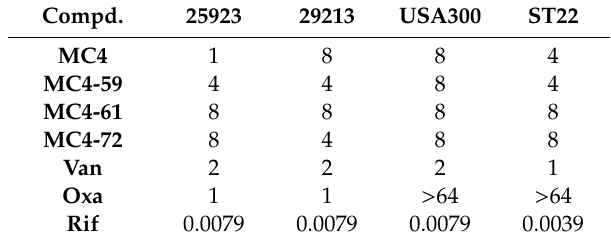
Table 1. Minimal inhibitory concentrations (MICs) expressed in µ g / mL of select MC4 family of nusbiarylins and control drugs used in this work against both methicillin-sensitive and resistant S. aureus strains cultured in TSB.